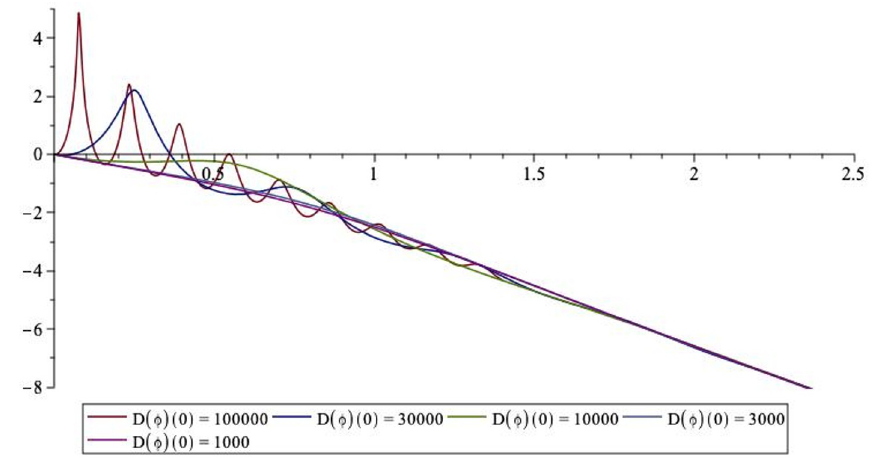
(cid:0) ( (cid:1) versus affine parameter x ( s ) − 1) 2 + y ( s ) 2 s = κ = 1 for concreteness. 0